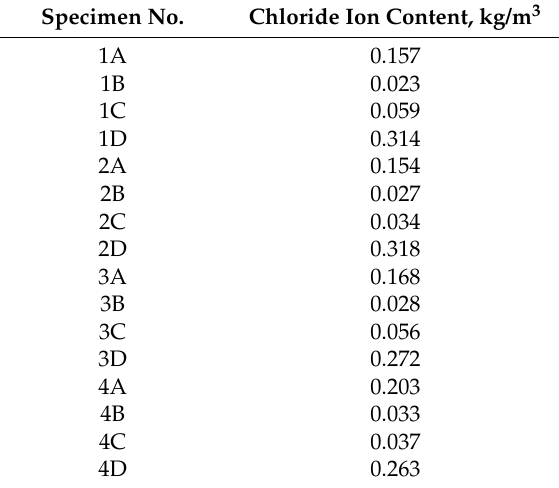
Table 4. Chloride ion content of